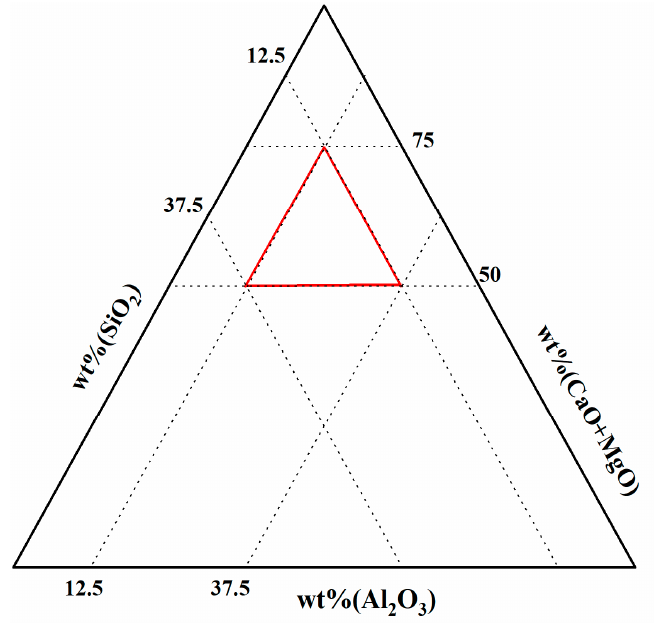
Figure 4. Red area shows the Slag composition of the (CaO + MgO)-SiO 2 -Al 2 O 3 pseudo-ternary system.